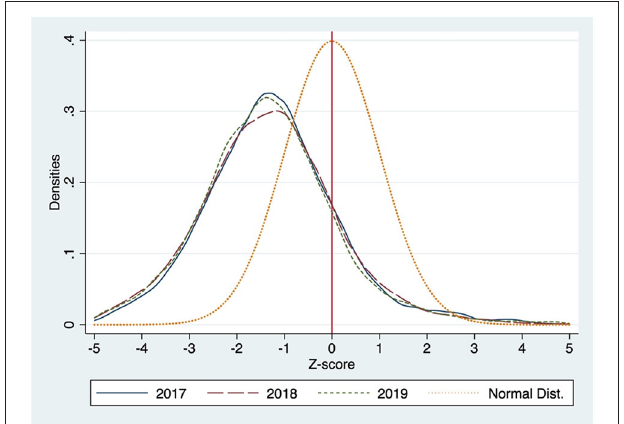
FIGURE 3 | Height-for-age z-score by sex in 2019. Source: Own elaboration based on Caritas Venezuela data. 95% confidence intervals.